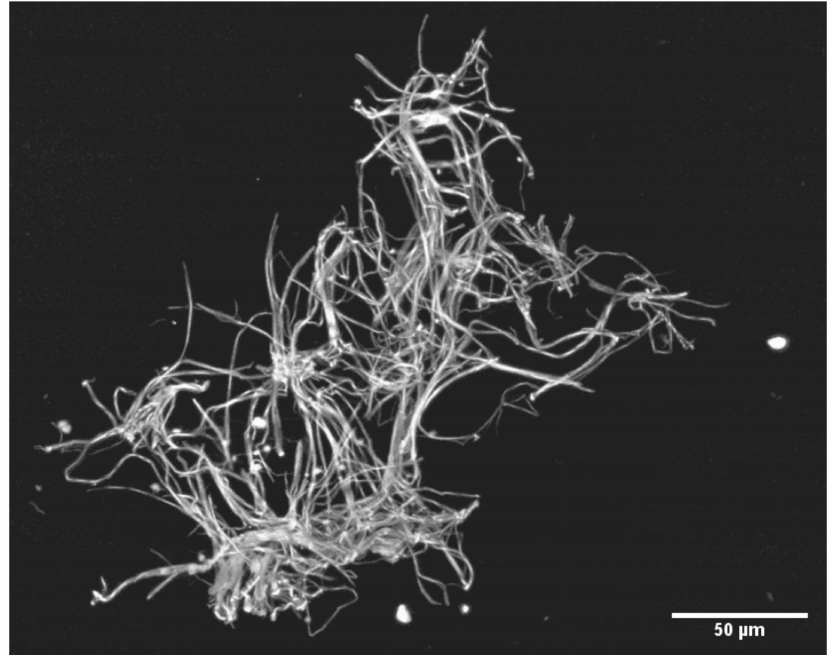
Figure 4. A larger microclot. Three-dimensionally reconstructed; maximum intensity images of